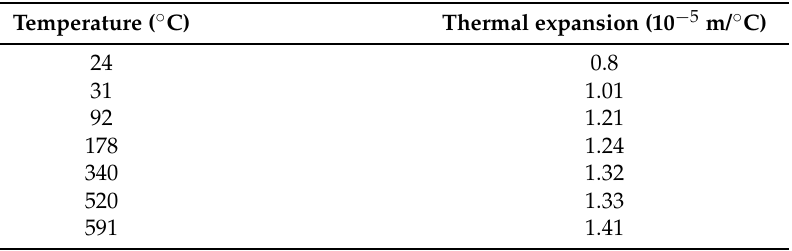
Table 1. Properties of Bi 2 Te 3 [32].